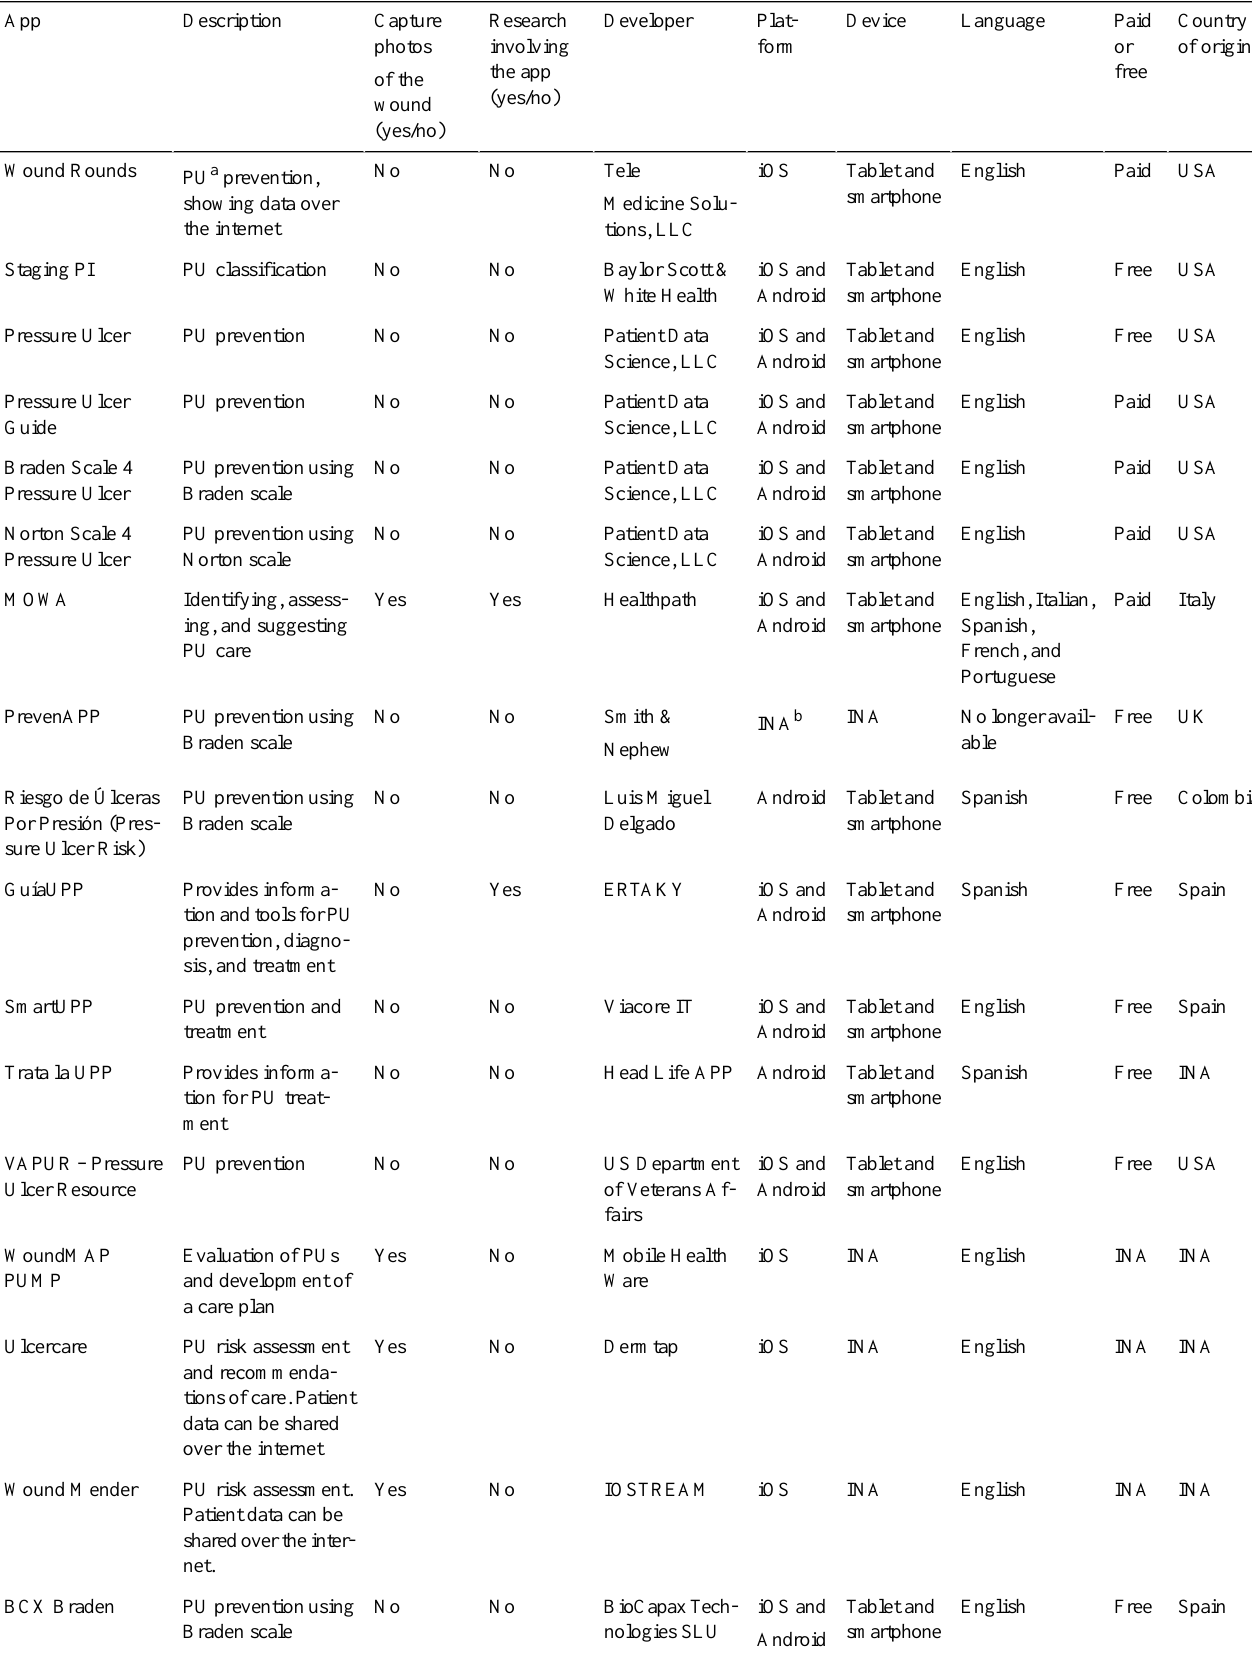
Table 1. List of apps found on websites and in web-based stores.